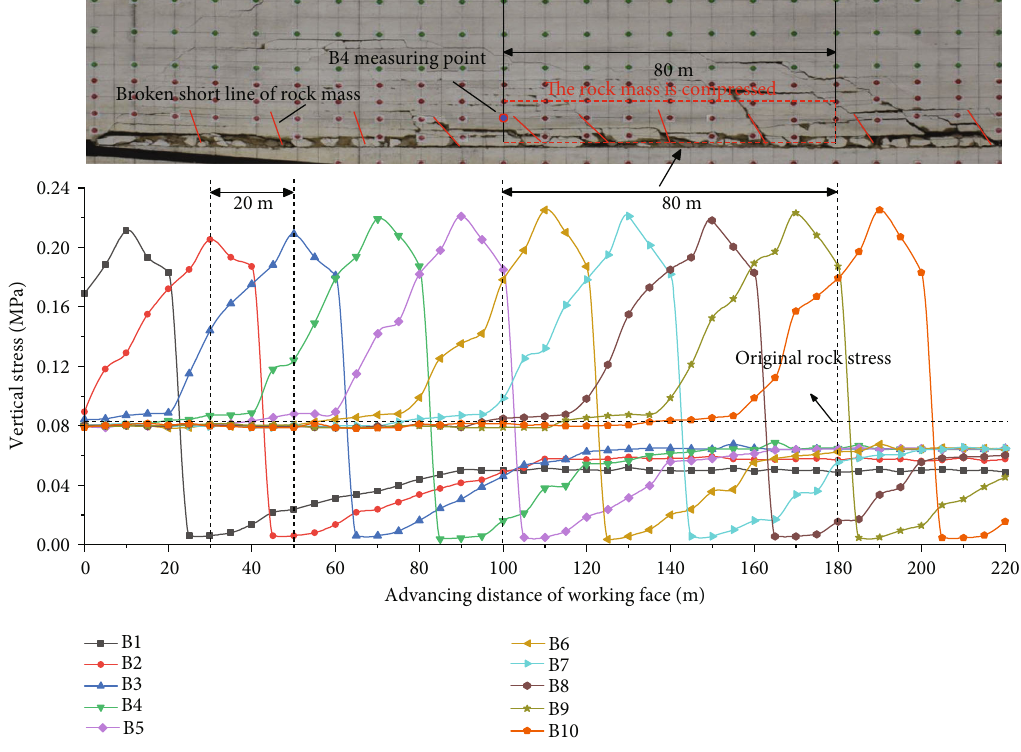
Figure 6: Stress variation diagram of overburden due to the mining in fl uence (B monitoring line).